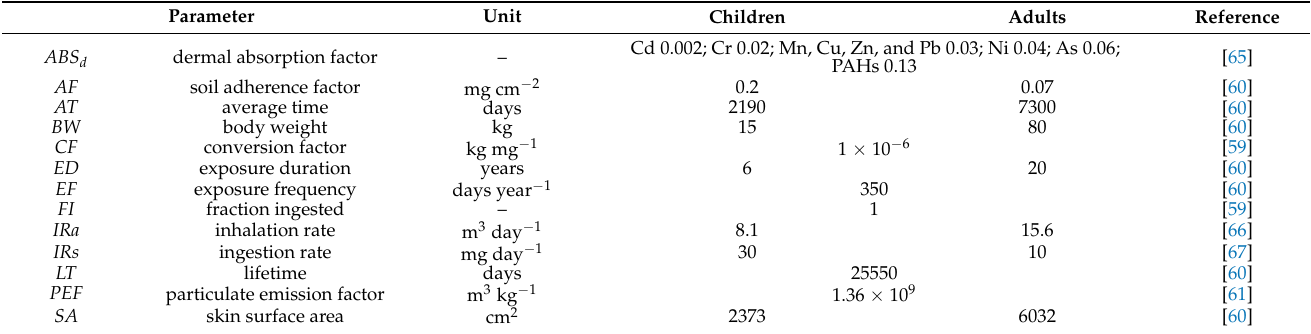
Table 4. Exposure parameters used for the health risk assessment.